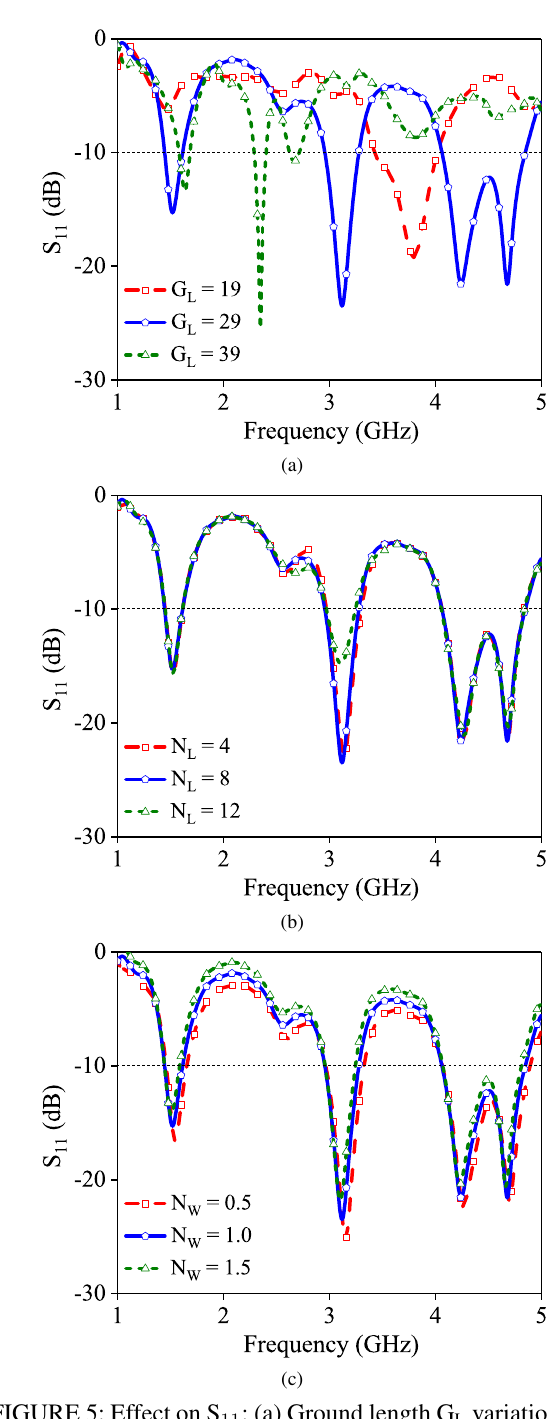
FIGURE 5: Effect on S 11 : (a) Ground length G L variation (b) Back notch length N L variation and (c) Back notch width N W variation